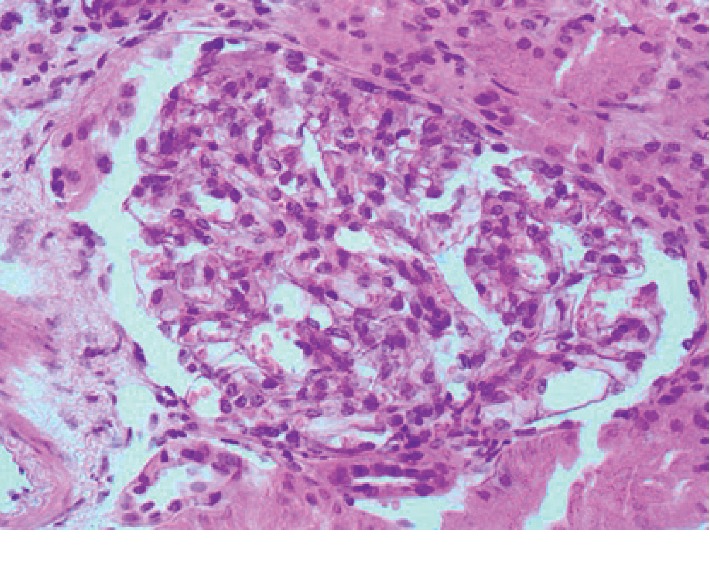
Glomerulus with no essential abnormalities; segmental and mild mesangial expansion at the time of lupus podocytopathy diagnosis (H&E, 400X).